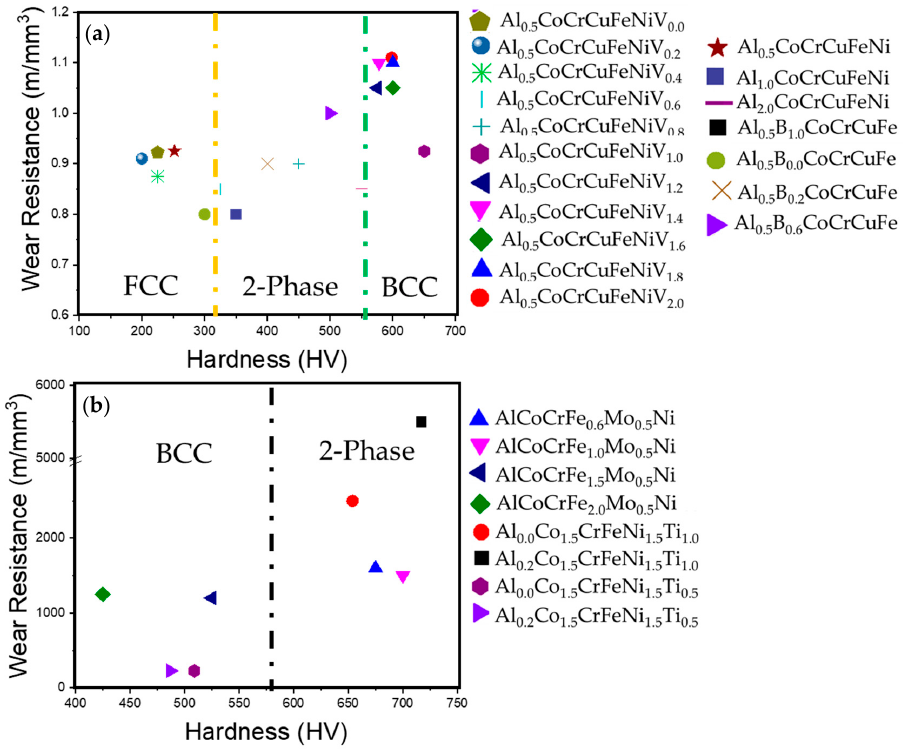
Figure 32. Hardness-wear resistance relationship classified with respect to their magnitude of wear resistance ( a ) less than 2.5 m/mm 3 ; ( b ) between 500 and 6000 m/mm 3 . The wear performance of the alloys do not show a particular dependency on the crystal structure.